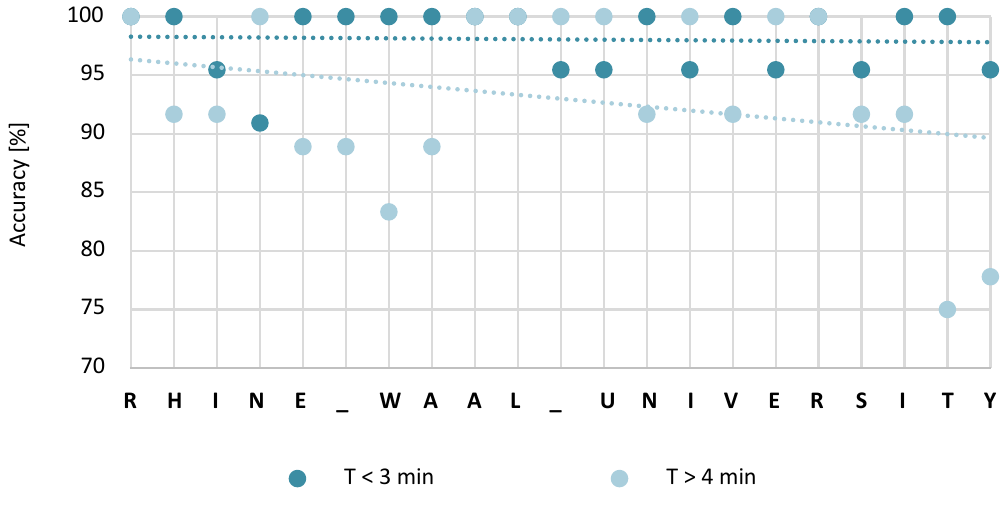
Figure 7. Steady-state visual evoked potentials classification accuracies over the experiment duration for slow and fast performers.